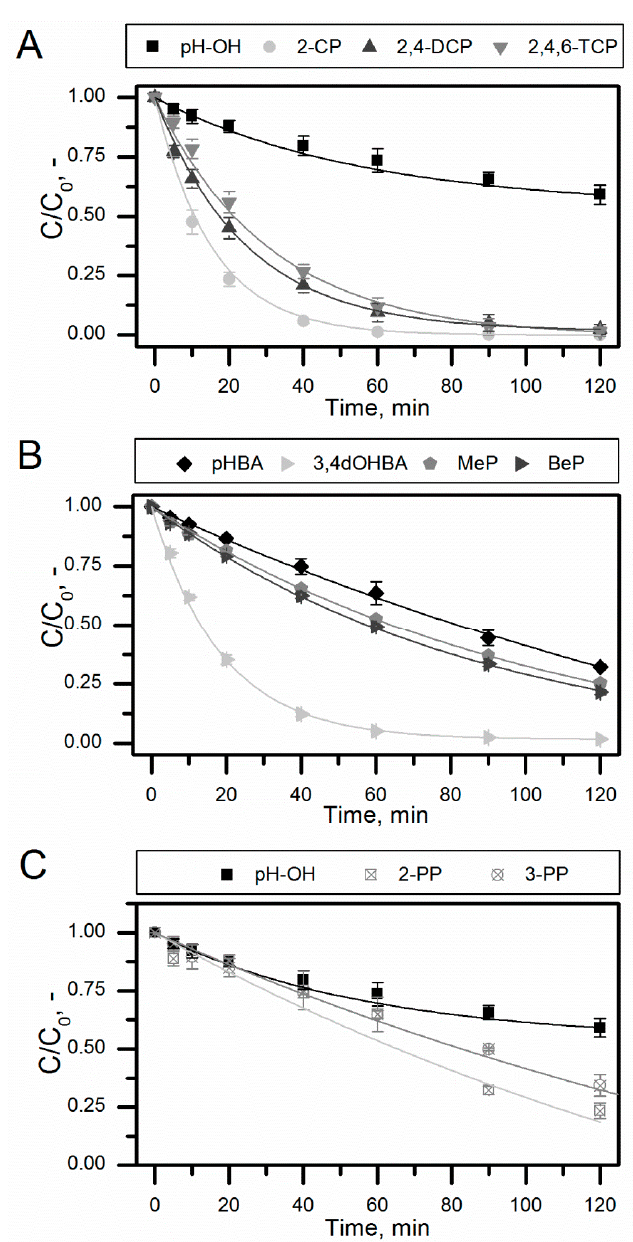
Figure 5. The relative concentration decreases of the phenolic compounds due to photosensitized oxidation in the aqueous solutions depending on the reaction time. ( A )phenol and cholorophenols; ( B ) pHBA and its derivatives; ( C ) phenol and